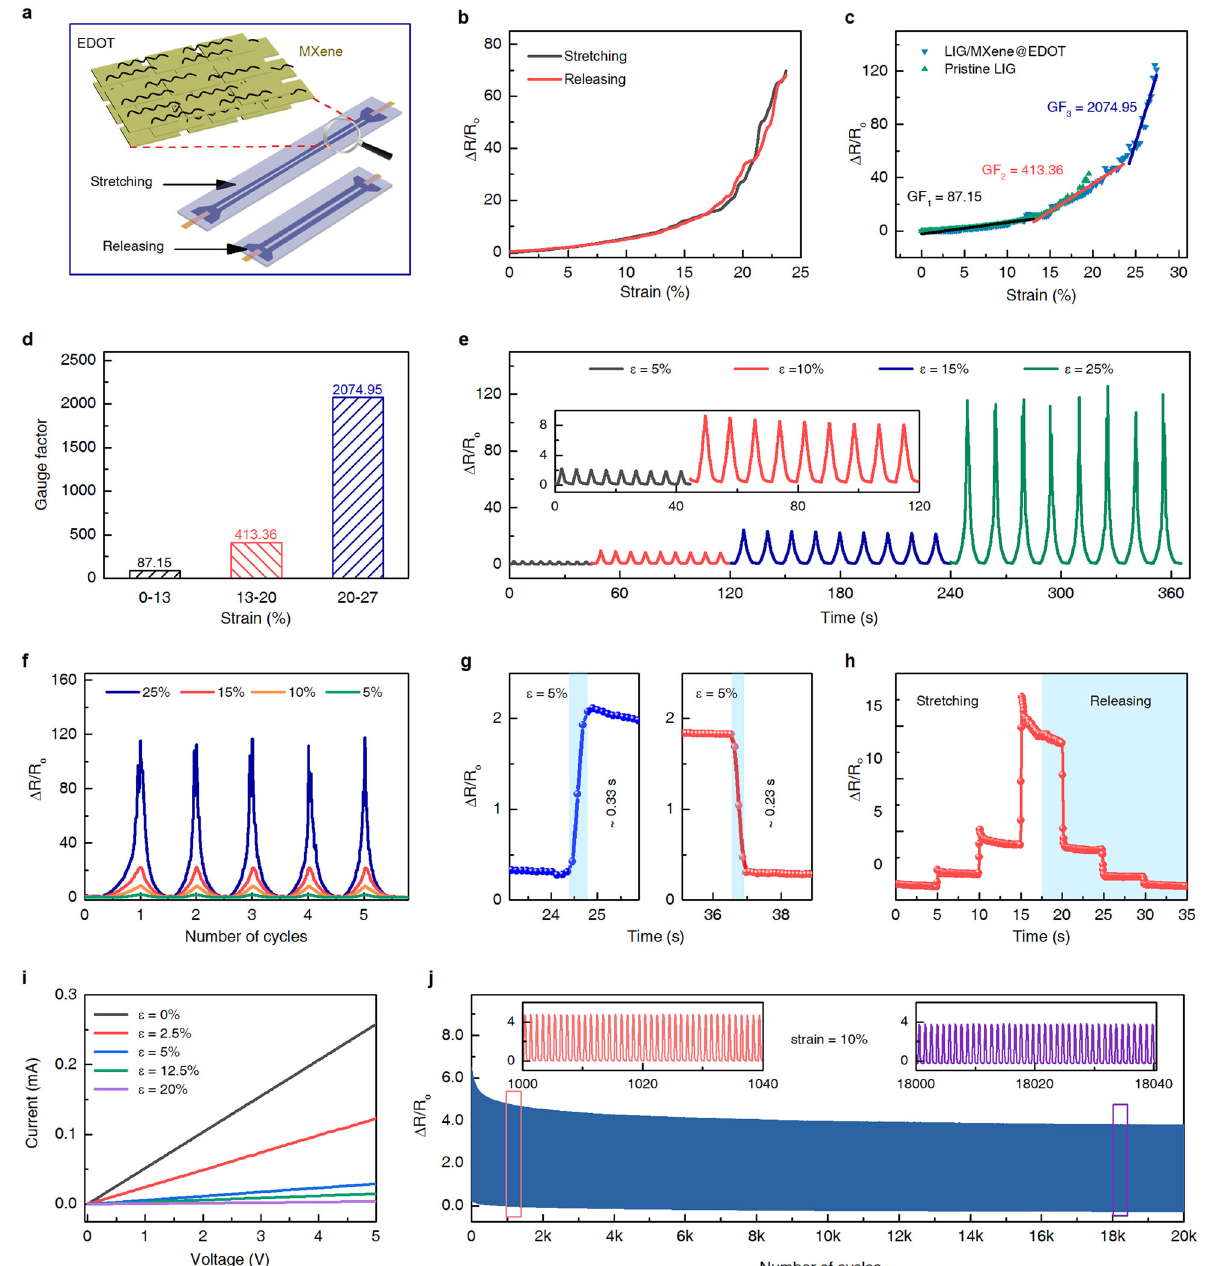
Fig. 3 Electromechanical characterization of strain sensor. ( a ) Schematics showing the mechanism of crack propagation during stretching. ( b ) Measurement of electrical hysteresis during stretching (black line) and releasing (red line) up to a safer limit of 23%. ( c ) Change in resistance vs. strain depicting strain sensitivity. ( d ) Statistical GFs at different strains. ( e ) Time-dependent and ( f ) corresponding cyclic response of the strain sensor for consecutive cycles of strains from 5 to 25%. ( g ) Calculation of dynamic response and relaxation time. ( h ) Sequential stretch and release process depicting reversibility of resistance response. ( i ) Veri fi cation of Ohm ’ s law showing the piezoresistive nature of the sensor. ( j ) Durability test of the sensor measured over 20,000